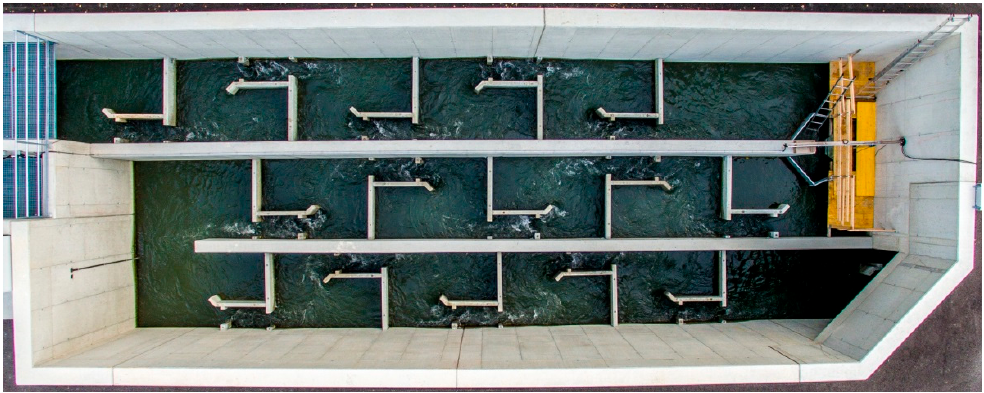
Figure 2. Meandering stream course in the enature ® fish pass, with multiple structured slots arranged in an alternating manner.